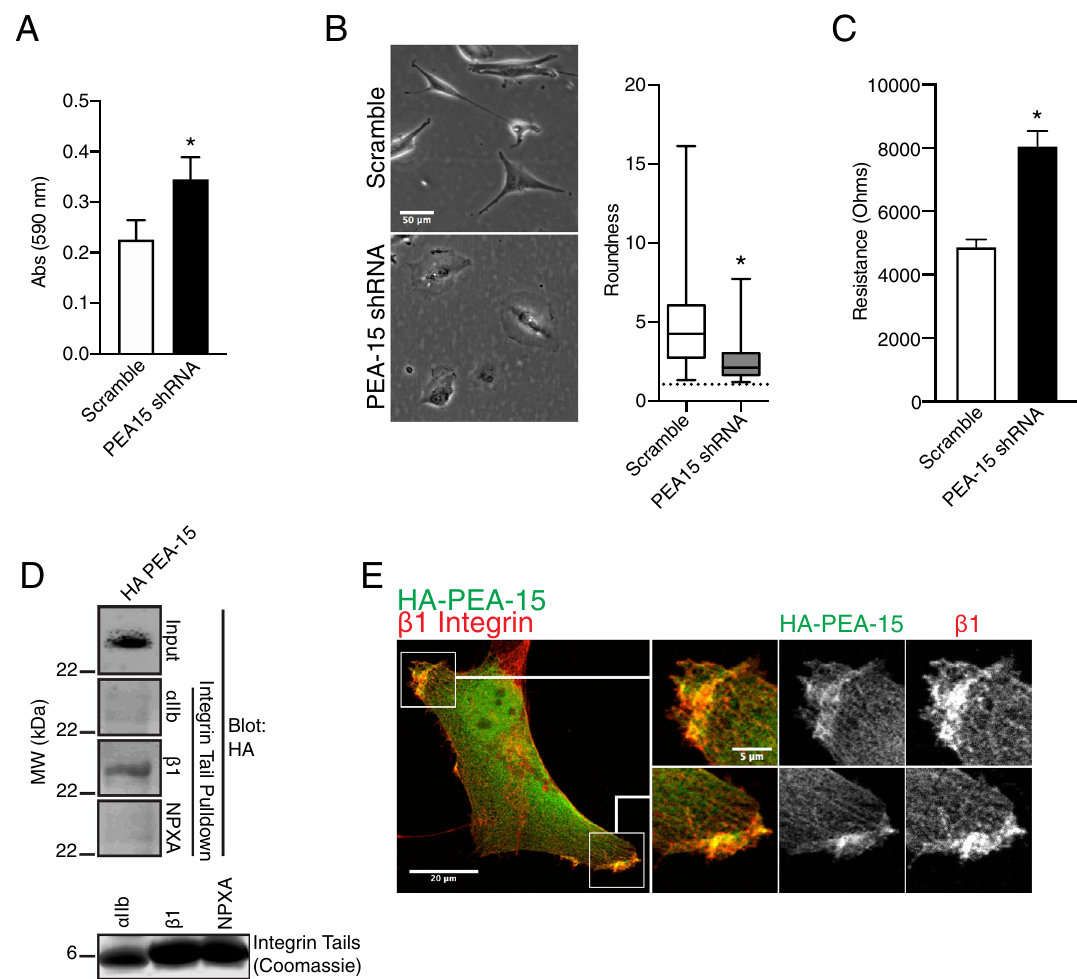
Figure 6. PEA-15 interacts with β1 Integrin. ( A ). U87MG PEA-15 knock down cells were plated on Fibronectin-coated plates. The number of adhered cells was then quantified by crystal violet staining and is shown as absorbance at 590 nm (n = 4, p < 0.005). ( B ) Scramble and PEA-15 KD were cells grown under normal growth conditions for 24 h in plastic tissue culture dishes. Bright-field images were acquired and cell area and perimeter were recorded and used to calculate a roundness index (the dotted line indicates a value of 1, corresponding to a perfectly circular morphology). PEA-15 KD cells displayed a significantly rounder and spread morphology compared to control cells (* p < 0.005, n = 150). Scale bar = 50 µm. ( C ) Equal numbers of scramble and PEA-15 KD cells were seeded then grown to confluence in ECIS chambers. The baseline resistance of PEA-15 KD cells at confluence is significantly increased compared to scramble control (* p < 0.005, n = 4). ( D ) Recombinant β1 integrin cytoplasmic tails were incubated with lysate from HeLa cells expressing HA-tagged PEA-15. NPXA = β1 membrane proximal tyrosine mutated to alanine, αIIb = αIIb integrin cytoplasmic tail. HA-PEA-15 was detected in precipitates by Western blot. ( E ) HA-PEA-15 was expressed in PEA-15 KD cells. Cells were fixed and immunostained for HA tag and β1 integrin. Scale bar = 20 µm; zoomed scale bars = 5